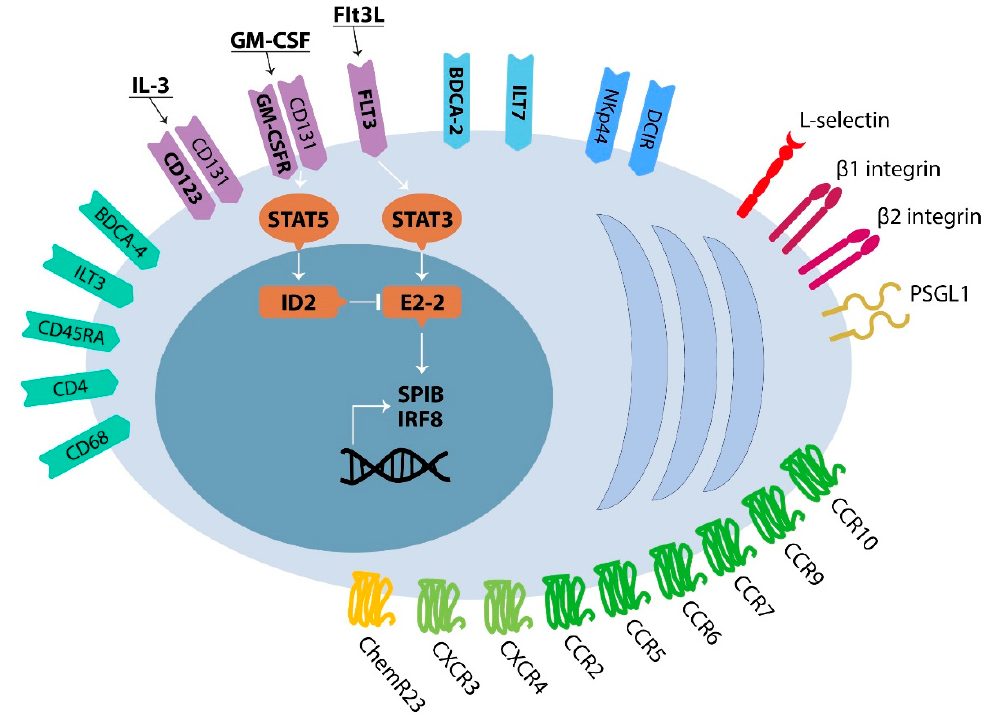
Figure 1. The phenotype of human pDCs. Graphical representation of the phenotype of a human pDC. Human pDCs express a broad range of surface antigens, adhesion molecules and chemotactic receptors. Among these, the surface receptors BDCA-2 and ILT7 are selectively express by human pDCs. Moreover, Flt3, GM-CSFR, and CD123 regulate the pDC development, homeostasis and survival via the ID2 and E2-2 transcription factors.